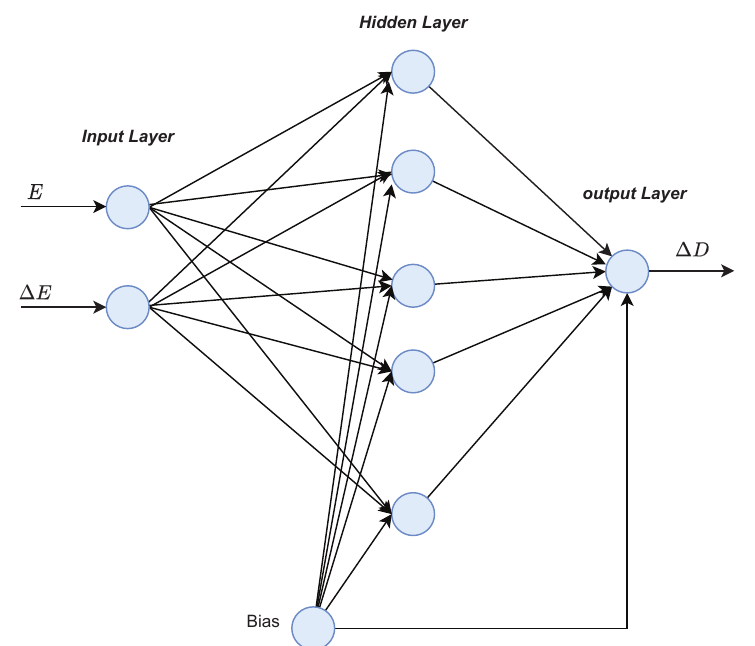
Figure 7. The proposed design of the artificial neural network (ANN) used for maximum power point tracking